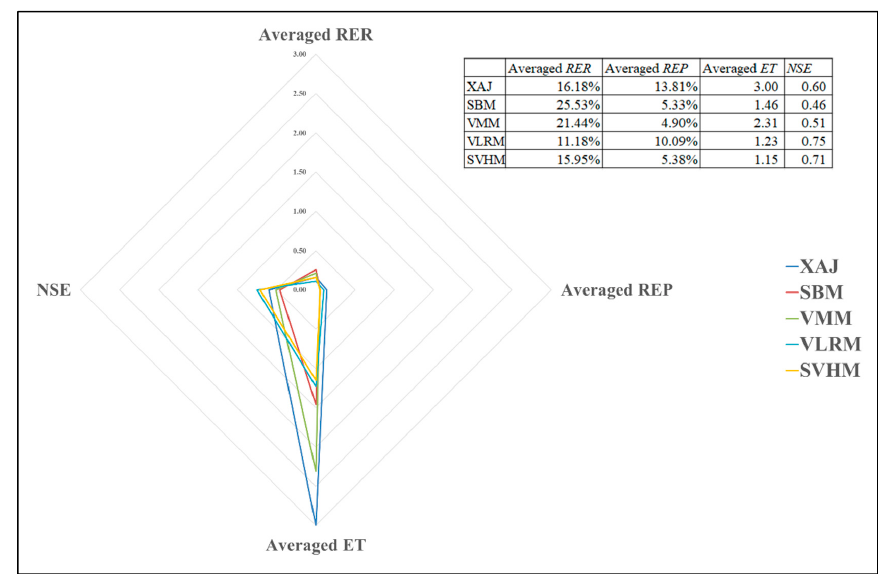
Figure 9. Comparisons of performance measures for different models in simulating all flood events in Zijingguan Basin (Note: REP denotes the relative error of flood peak, RER denotes the relative error of total runoff depth, ET denotes the error of peak appearance time and NSE denotes the Nash–Sutcliffe efficiency coefficient. REP, RER and NSE range from 0 to 1 and ET ranges from 0 to 3). For Xiuwu Basin (Figures 10 and 11), it can be seen that the simulation by SBM has the lowest RQR (50.00%) and RQ (52.22%) among the five models. VMM has more qualified results (RQ =